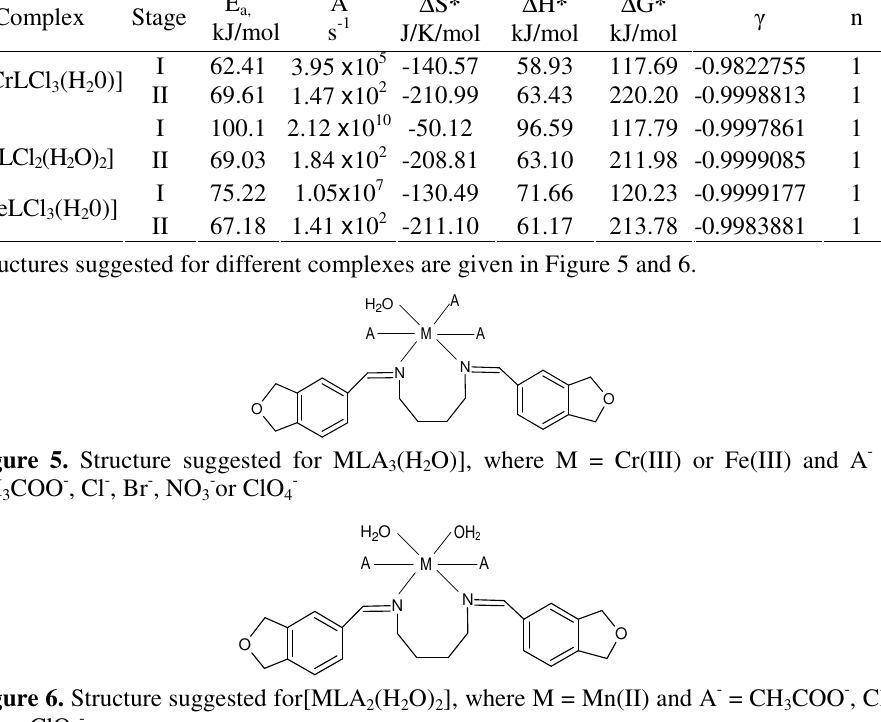
Table 5. Kinetic parameters for the decomposition of Co(II), Ni(II) and Cu(II) Complexes.